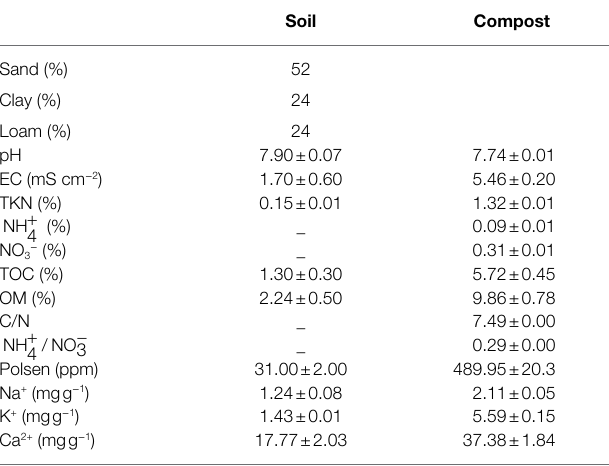
EC, electrical conductivity; TKN, total Kjeldahl nitrogen; TOC, total organic carbon; OM, organic matter; C/N, carbon-to-nitrogen ratio; and P, phosphorus. Values represent the mean ± standard deviation